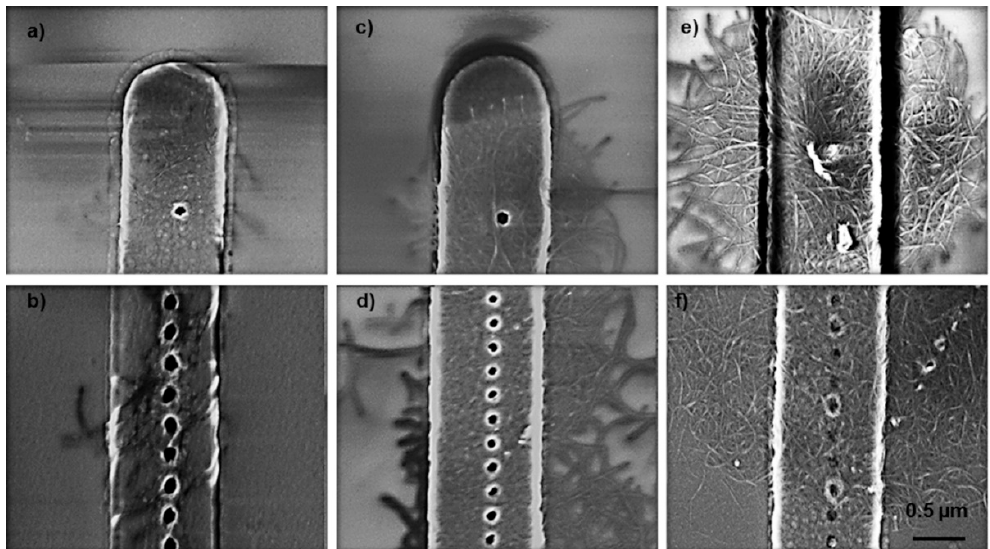
Figure 7. SEM images of EPD results with m-SWCNT (average length 781 nm) with deposition times of ( a ) and ( b ) 1 s, ( c ) and ( d ) 2.5 s, and ( e ) and ( f ) 5 s in isolated windows ( a , c , e ) and linear dense arrays ( b , d , f ).